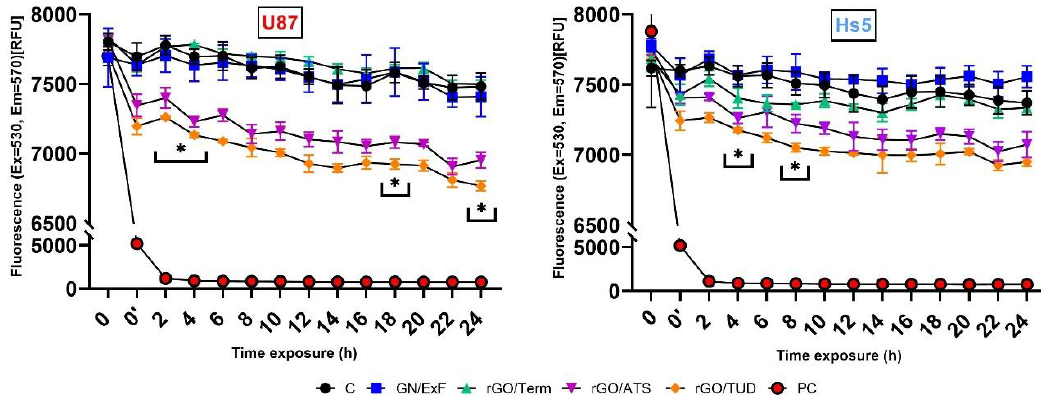
Figure 3. Effect of graphene flakes (GN/ExF) and three types of reduced graphene oxide flakes (rGO/Term, rGO/ATS, and rGO/TUD) on the membrane potential of U87 and Hs5 cell lines. The immediate reading after the addition is marked as 0 on the x -axis of the membrane potential sensor. PC represents the group after H 2 O 2 (hydrogen peroxide) treatment as positive control. The reading after 30 min incubation with a membrane potential sensor is marked as 0 (cid:48) on the x -axis. The readings were taken for 24 h at 2 h intervals. Values are expressed as mean ± standard deviation. Statistical significance between the control and treated cells is indicated by an asterisk and was assessed using Bonferroni’s multiple comparisons test. Differences with p -value < 0.05 were considered significant. One asterisk ( * ) means p -value < 0.05. Abbreviations : rGO, reduced graphene oxide; GN, graphene; C, control group (untreated group); PC, positive control; h, hours; ExF, exfoliation; Term, thermal; ATS, ammonium thiosulphate; TUD, thiourea